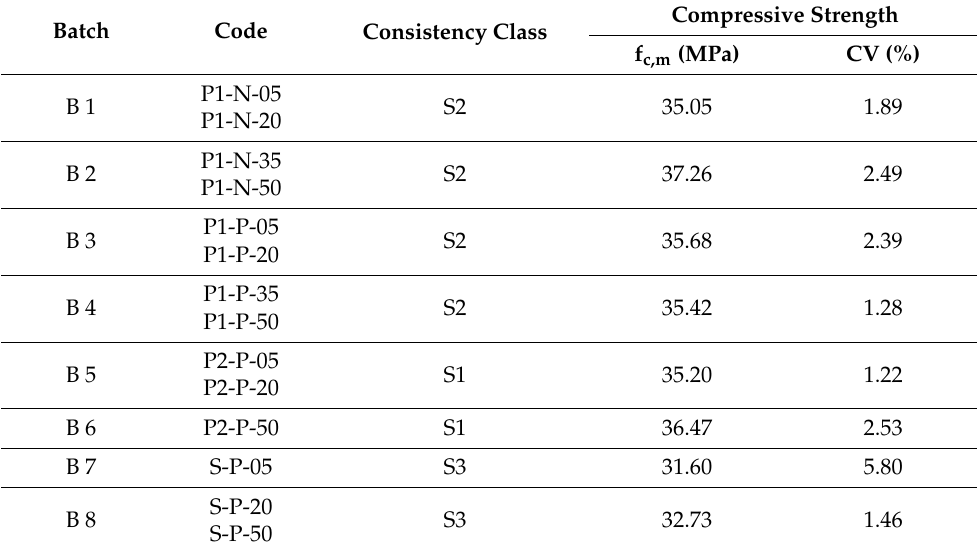
Table 5. Consistency class and compressive strength of all